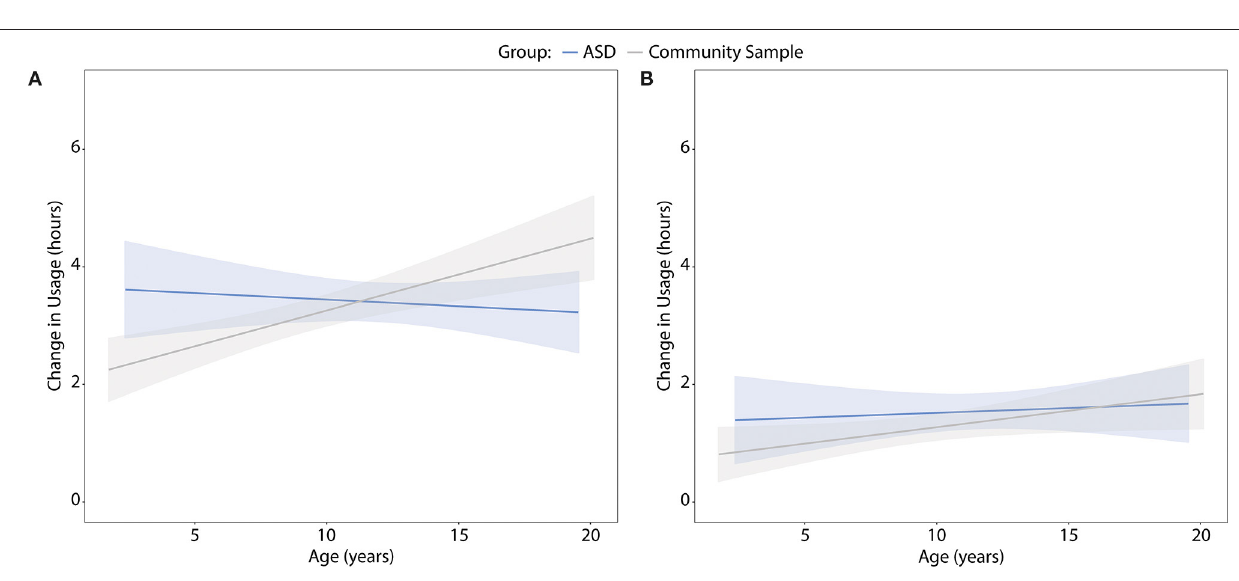
time spent on social media [family QoL OR = 0.7 (95% CI 0.50, 1.01), p = 0.05; child’s mental health OR = 0.6 (95% CI 0.44, 0.89), p =